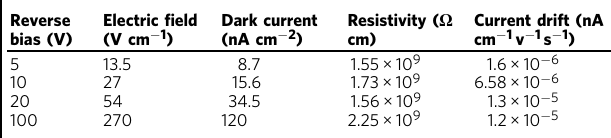
Table 2 Dark current drift and resistivity result of the MAPbI 3 crystal with DPSI after surface treatment in Fig.